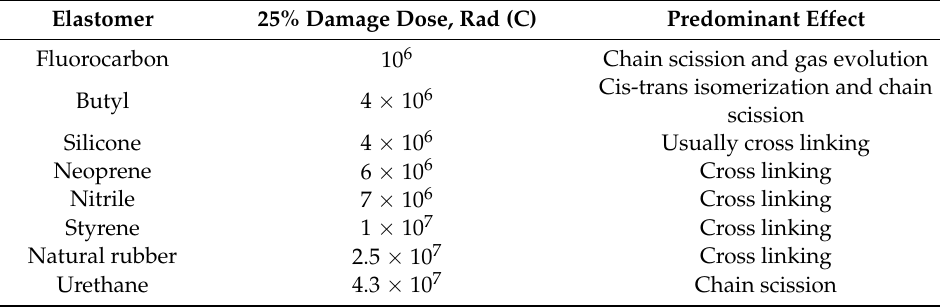
Table 3. Summary of radiation effects on elastomers